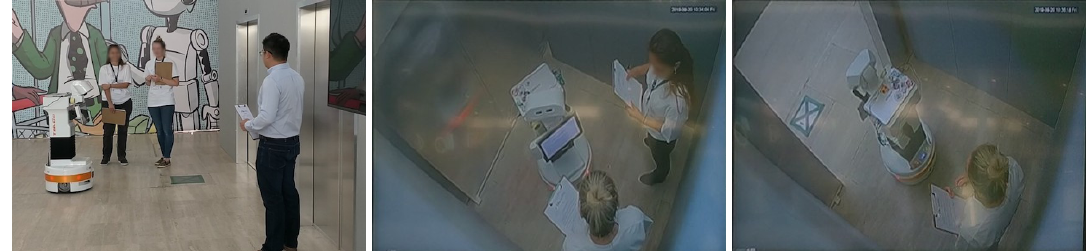
Figure 10. Take the elevator challenge in SciRoc